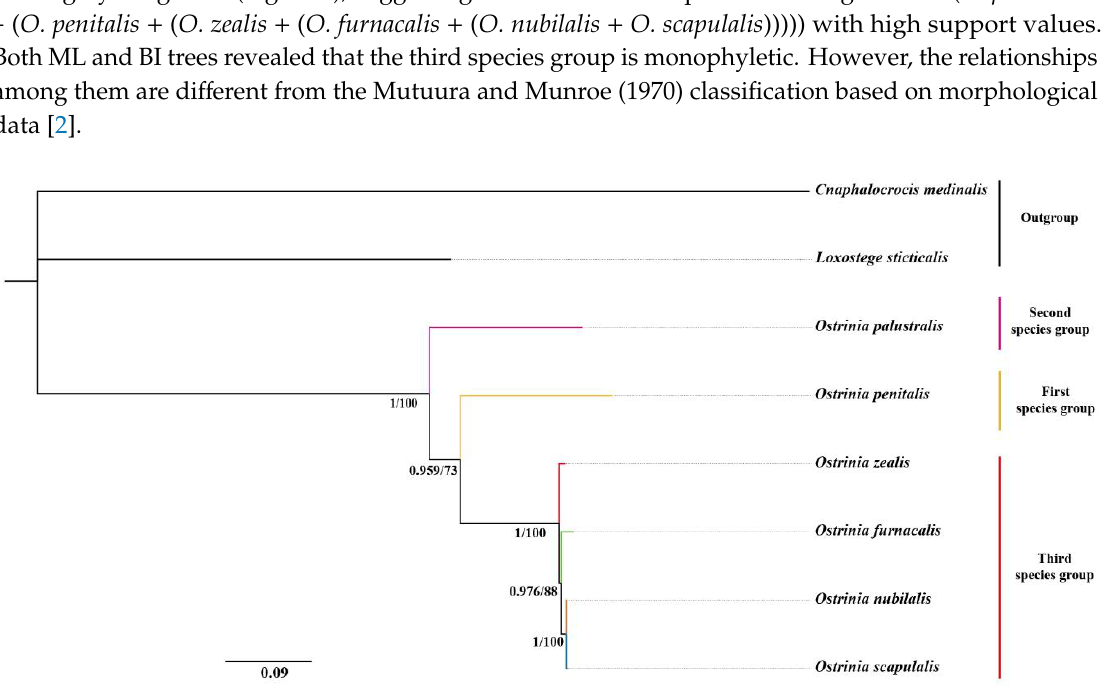
Figure 6. The phylogenetic tree of Ostrinia spp. based on the dataset of PCG123. ML and BI analyses show the same topology. The numbers under the branches are Bayesian posterior probabilities (PP) and bootstrap support values (BS). Scale bar represents nucleotide substitutions per site.